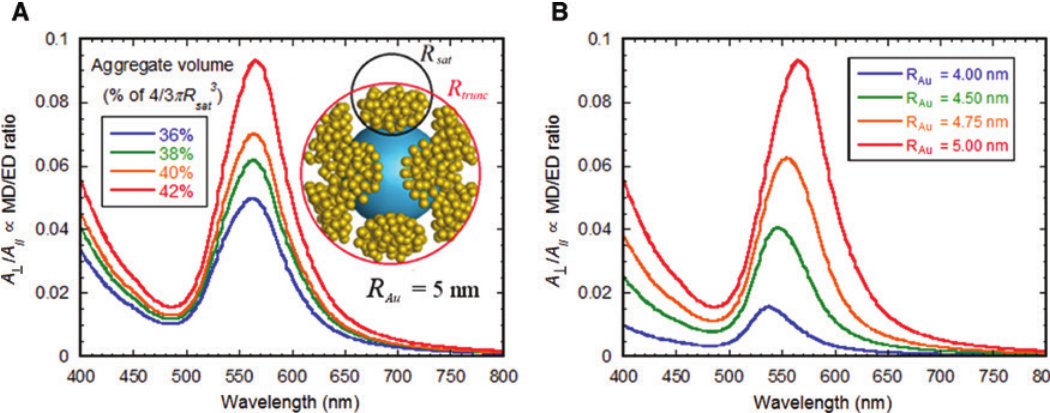
Figure 8: Simulated optical properties of uncondensed dodecapods. (A) Plot of the computed magnetic to electric estimator A / A versus wavelength for different volumes of gold aggregates in noncondensed ⊥ // dodecapods. The cartoon illustrates the construction of the structure: the volume of the aggregates is defined as the intersection of 12 spherical satellites of radius R (black circle) with a truncation sphere of radius R (red circle). These volumes are filled with sat trunc = 5 nm with a volume fraction set to 40%. The volume of the aggregates, controlled by R nonintersecting gold nanospheres of radius R Au is given as a percentage of the volume of the full satellite sphere 4/3 π R sat3 . (B) Same A / A ratio computed at constant aggregate size but ⊥ // for different radii R . The number of particles is kept constant; consequently, the volume fraction of gold increases. Note the red shift of the Au magnetic resonances with increasing size of the gold